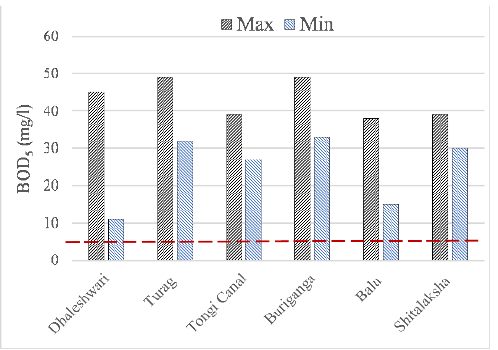
Figure 5. Max m vs. Min m Concentration of BOD 5 in the peripheral rivers of Dhaka with WHO standards (5 mg/L).